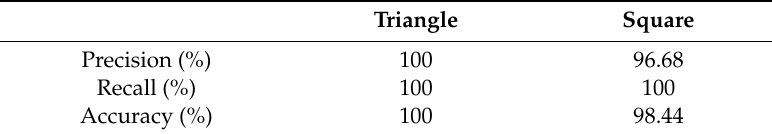
Figure 19. Operation process: ( a )–( e ) The second layout style.